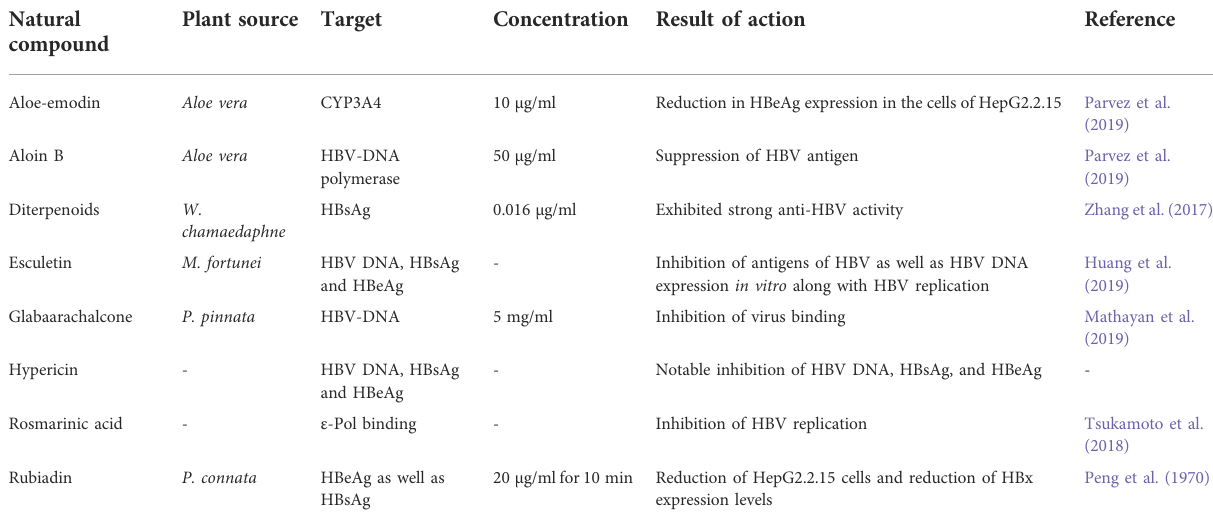
TABLE 2 Natural products for hepatitis B